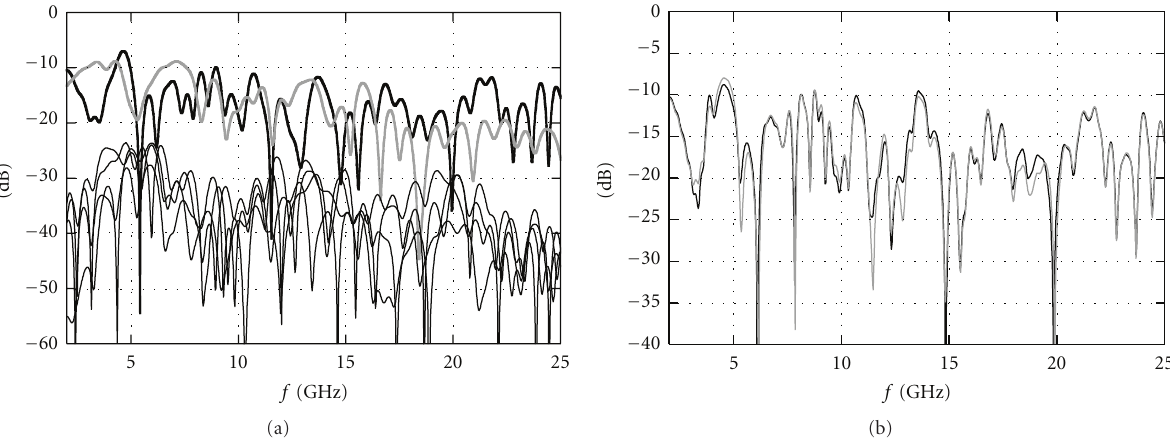
Figure 10: Array of 3 adjacent shielded cells as in Figure 2 at 5GHz. (a) Only the input port 3 feeds the lower patches in the central cell. Magnitude of reflection coe ffi cient ( thick black line ), of the coupling coe ffi cient with a cable connected to the upper patch in the same cell ( thick gray line ), and of coupling coe ffi cients with cables in an adjacent cell ( thin black lines ). (b) All the three lower sets of patches as fed in phase through port 3 (see Figure 2) and the respective translated ports in the other two cells. Magnitude of the active reflection coe ffi cient versus frequencies at the middle cell of the 3 × 1 array ( black line ) and at one side cell ( gray line